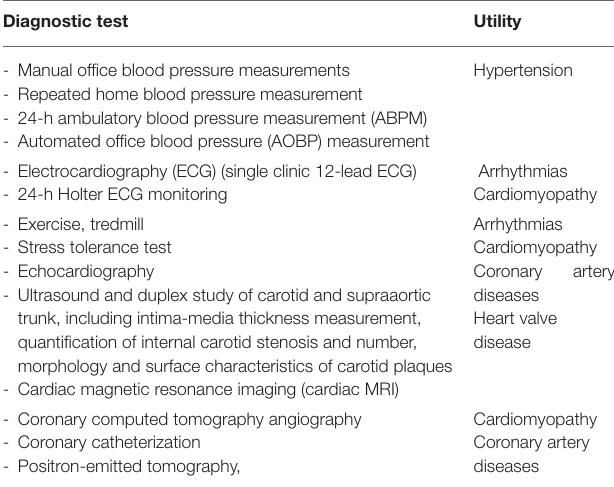
TABLE 1 | Summary of the diagnostic tests that may be used to identify the different cardiovascular alterations in patients with acromegaly. Diagnostic